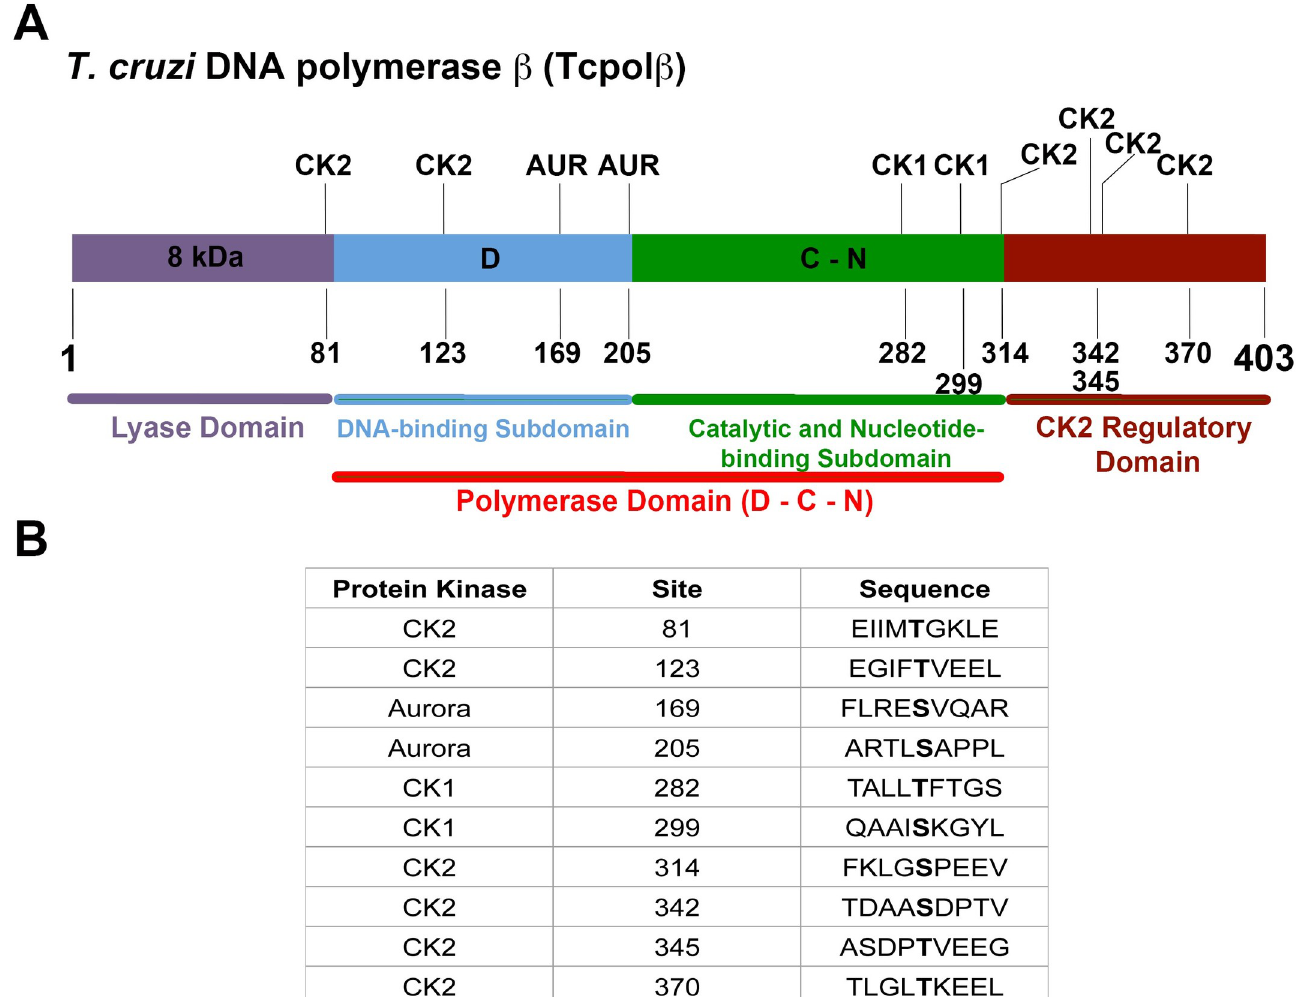
Fig 1. Schematic representation of Tcpol β . A) The enzyme displays a three-domain structure with an 8 kDa N-terminal lyase domain (purple), a middle DNA- binding subdomain (D, sky blue), a catalytic and nucleotide-binding subdomain (C-N, green) and a putative C-terminal domain, which we named CK2 regulatory domain, since possesses four CK2 phosphorylation sites (brown). This extra C-terminal domain is absent in human DNA pol β . Also, the positions of the protein kinase phosphorylation sites are indicated. B) Phosphorylation sites by the three indicated protein kinases (sequence and position) are indicated. Note that those sites do not